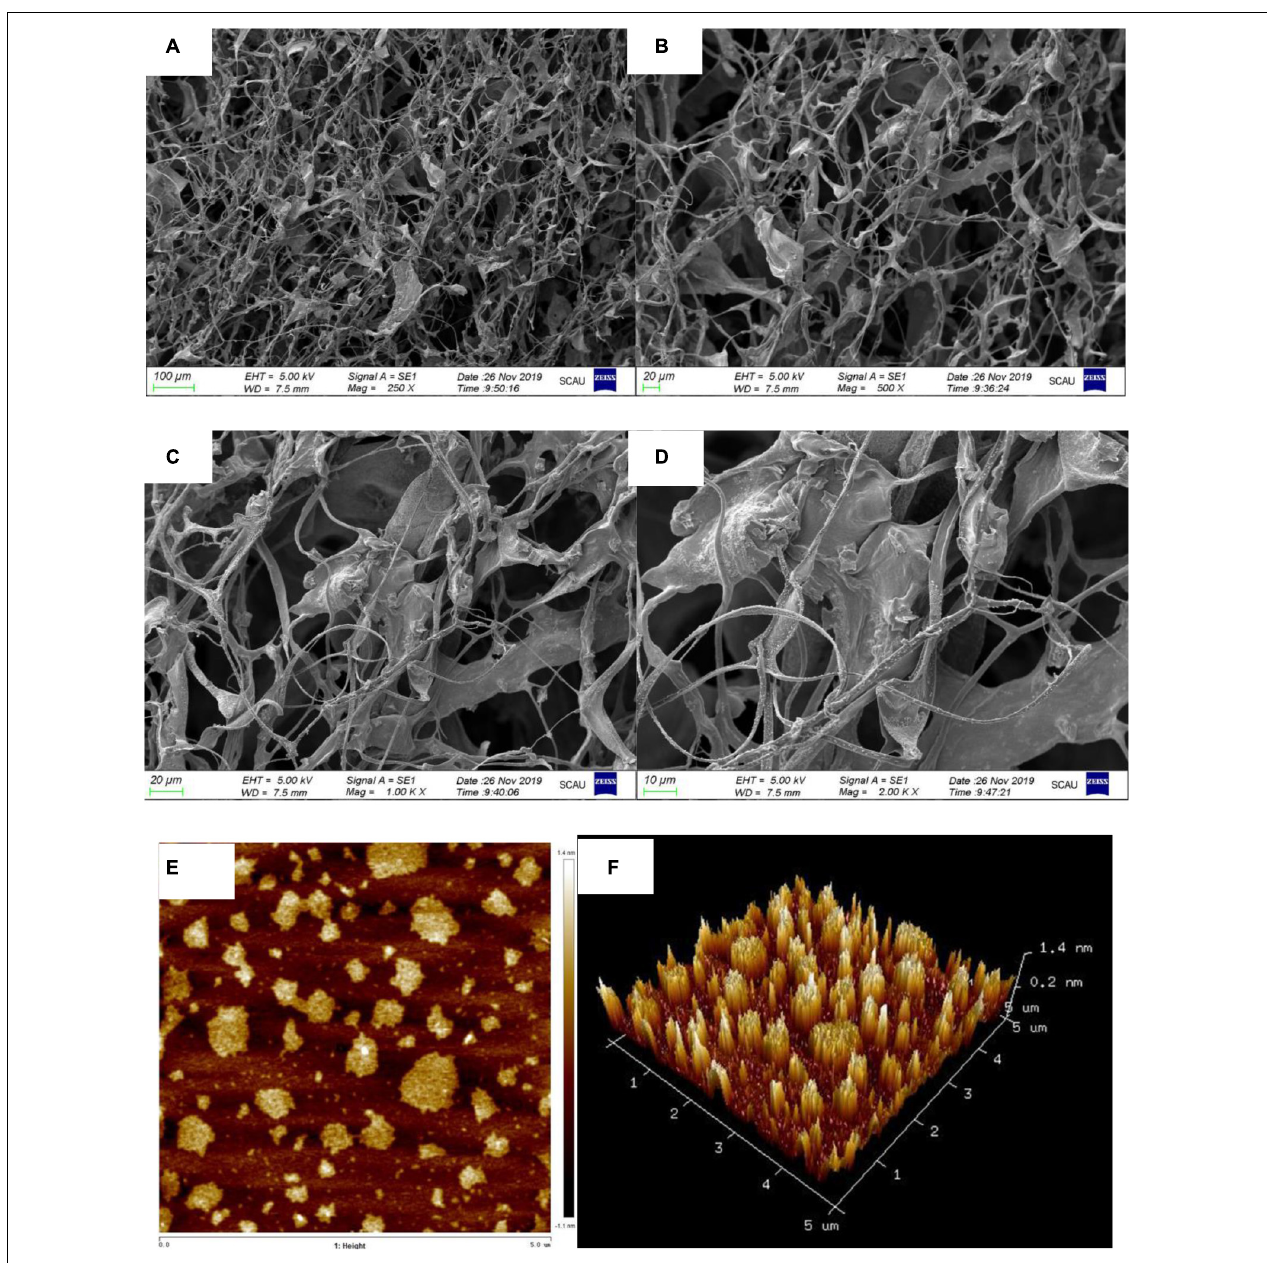
FIGURE 5 | SEM image with different magnifications × 250 (A) ; × 500 (B) ; × 1,000 (C) ; × 2,000 (D) ; AFM height analysis images (E) ; and three dimensional image (F) of